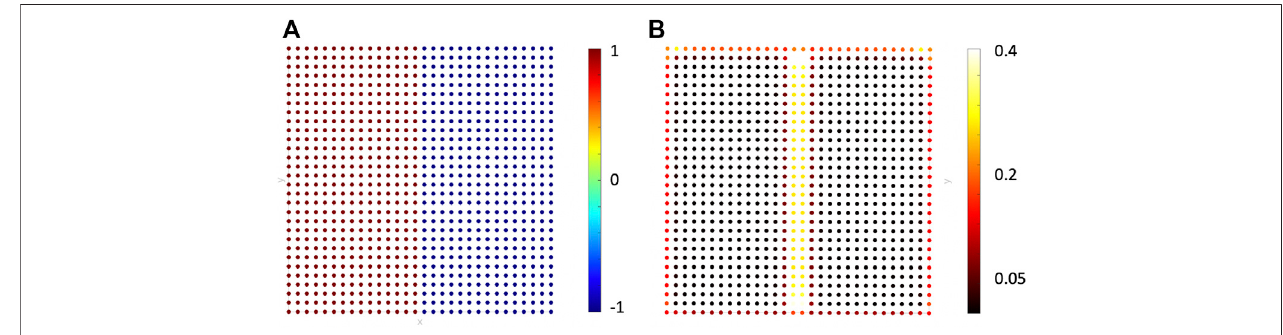
FIGURE 7 | Results of the application of MAHF ( k = 1) on a two-valued signal (in panel (A) ). We compute the MAHF, and we report the square of the module of the output in panel (B) .